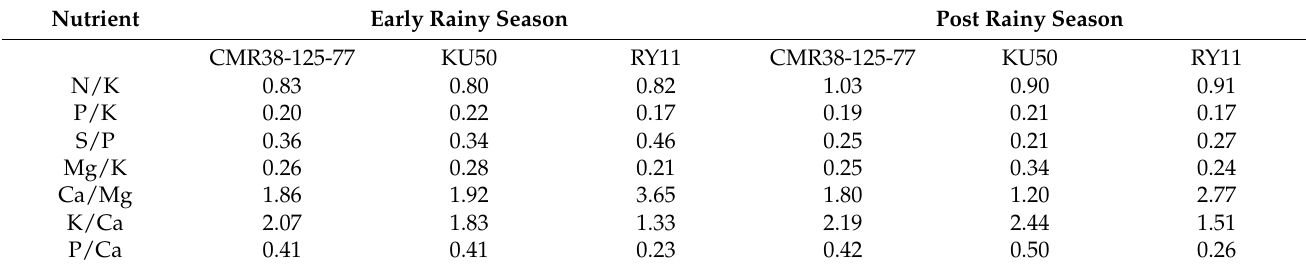
Table 7. The nutrient uptake ratios of three cassava genotypes at final harvest, planted in the early rainy season (ERS) and post rainy season (PRS) with full irrigation. Nutrient Early Rainy Season Post Rainy Season CMR38-125-77 KU50 RY11 CMR38-125-77 KU50 RY11 N/K 0.83 0.80